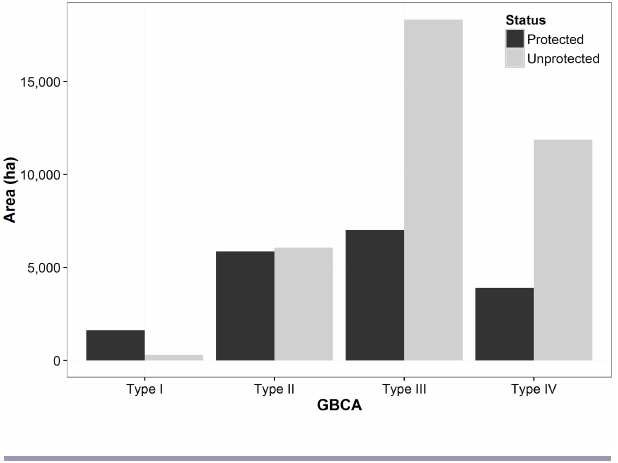
Fig. 2 . Hectares of protected and unprotected grassland habitat classified as Type I–IV Grassland Bird Conservation Areas (GBCAs). See Table 3 for definitions of GBCA